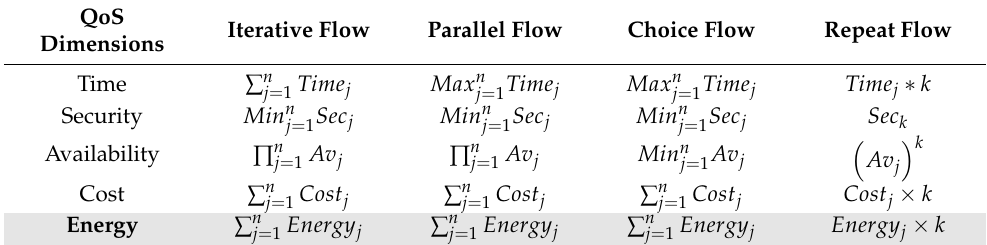
Table 3. QoS and Energy Process